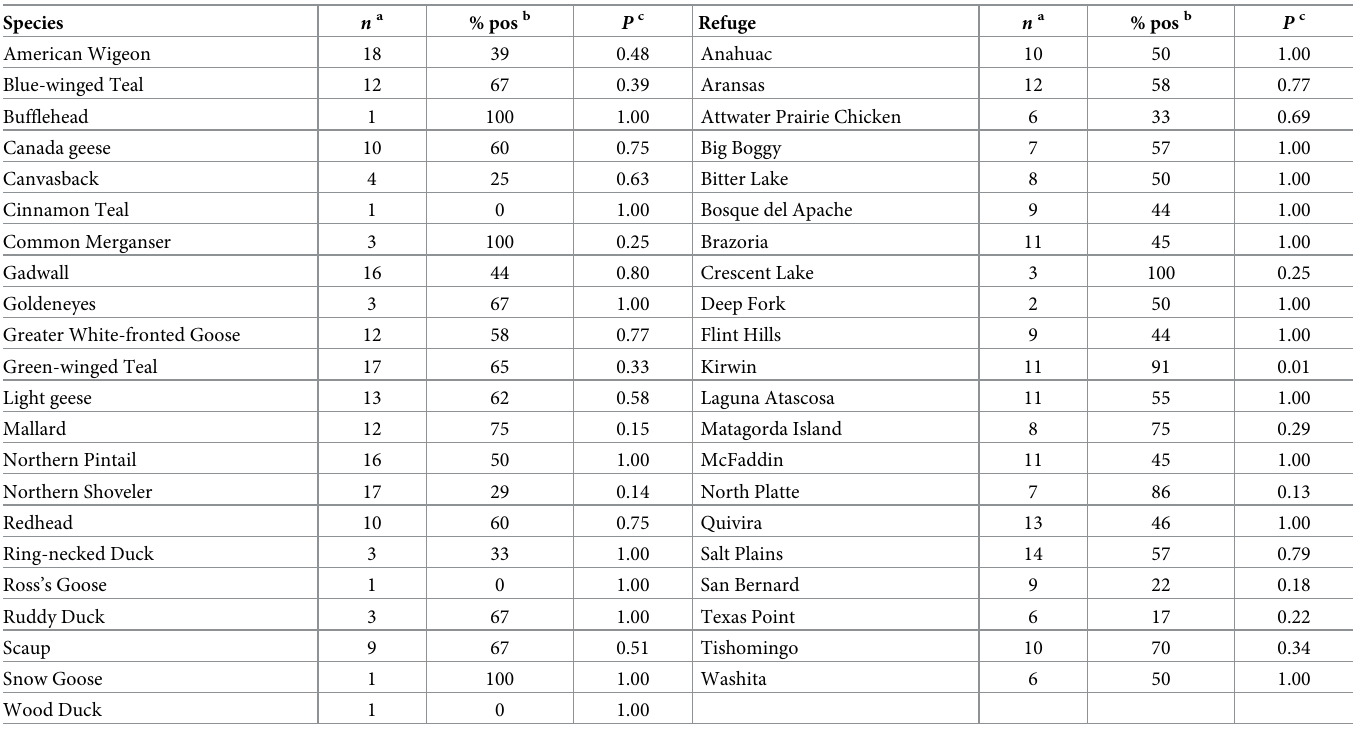
Table 4. Skewness in the distribution of slopes indicating advancements or delays in autumn peak with increasing temperature by waterfowl species and